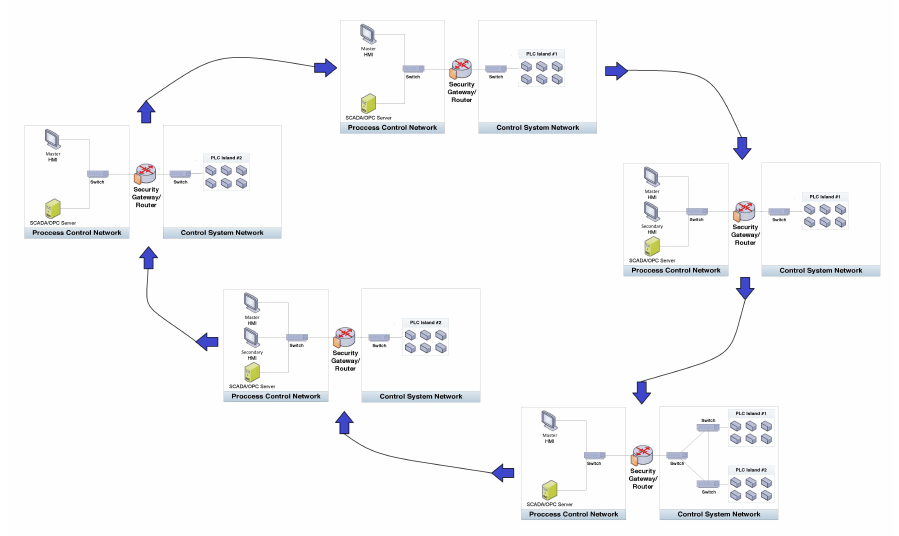
Figure 7. Topology of system circles between five different configurations